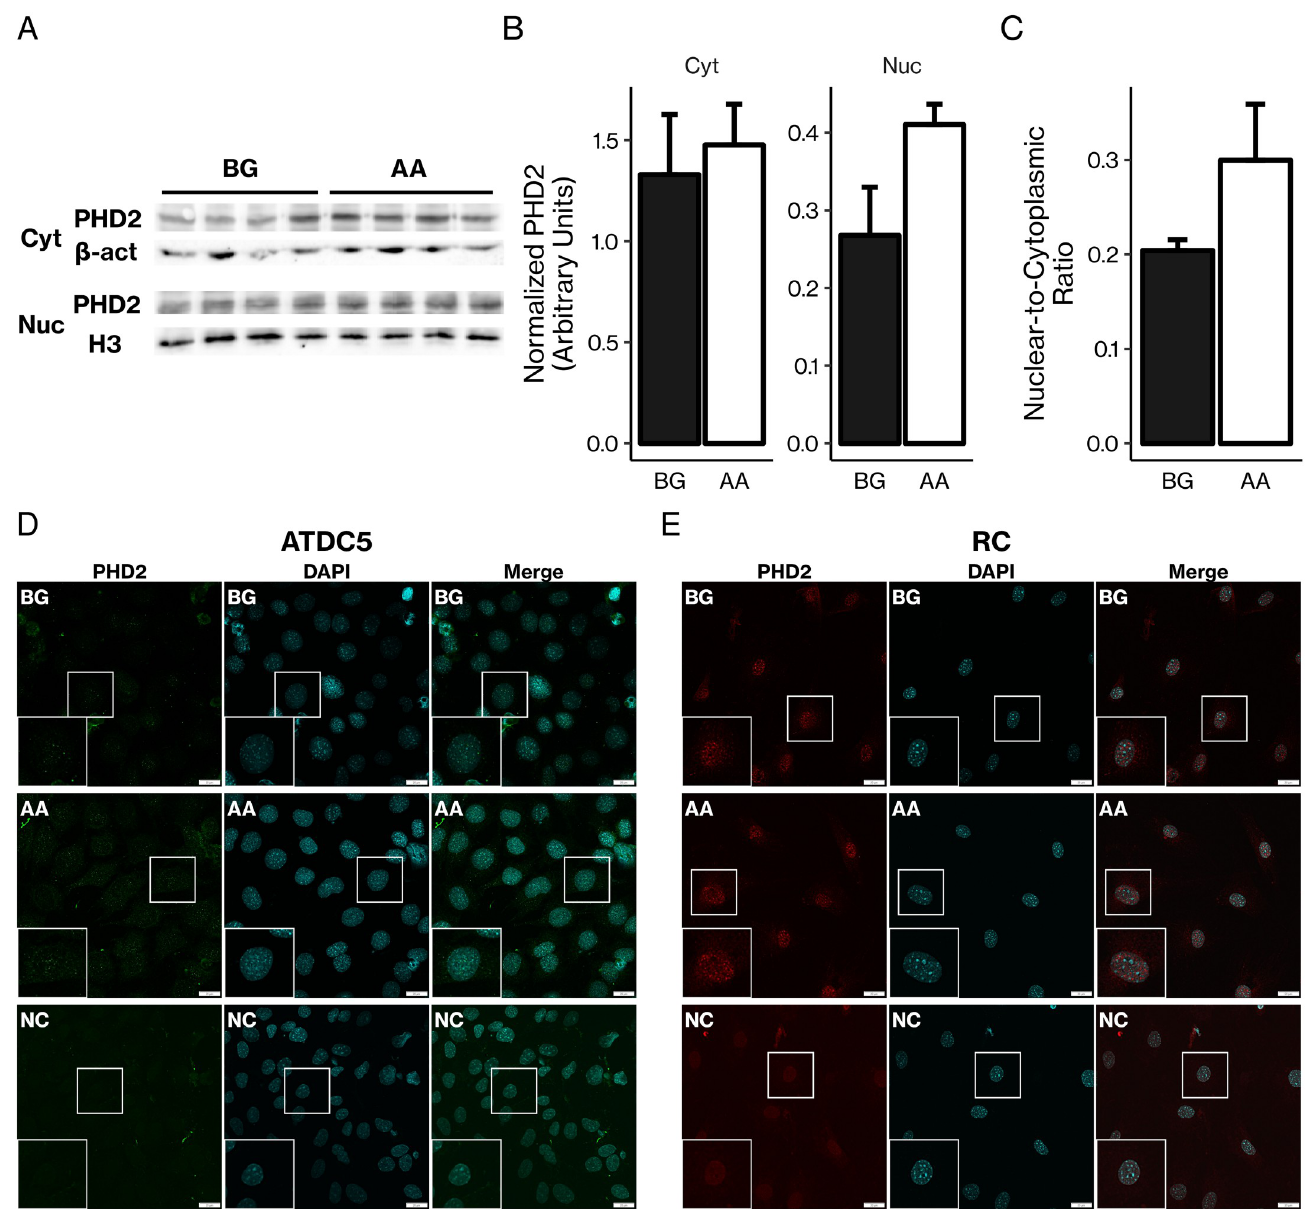
Fig 6. PHD2 is expressed in both the cytoplasm and nucleus at the protein level. (A) MC3T3-E1 pre-osteoblasts were treated with β -glycerophosphate (BG) with or without AA before cytoplasmic (Cyt) and nuclear (Nuc) protein extraction and SDS-PAGE followed by immunoblotting. Loading controls were β -actin ( β - act) for the cytoplasmic fraction and histone 3 (H3) for the nuclear fraction. (B) Immunoblots were quantitated with ImageJ, and signals from each fraction and treatment group were normalized to the respective loading control signals to produce quantitated, normalized PHD2 levels in the cytoplasmic and nuclear fractions. (C) The nuclear fraction signal was divided by the cytoplasmic fraction signal to give an indirect measure of the ratio of PHD2 levels in the nucleus vs. cytoplasm. AA treatment did not significantly change the nuclear-to-cytoplasmic ratio ( P = 0.2, Student’s t -test). Results are presented as mean ± SEM. n = 4 per group. (D) ATDC5 chondrocytes immunostained for PHD2. Inserts are magnifications of indicated regions. NC = negative control. Green = PHD2; blue = DAPI. (E) Rib chondrocytes immunostained for PHD2. Inserts are magnifications of indicated regions. NC = negative control. Red = PHD2; blue = DAPI. Scale bars = 20 μ